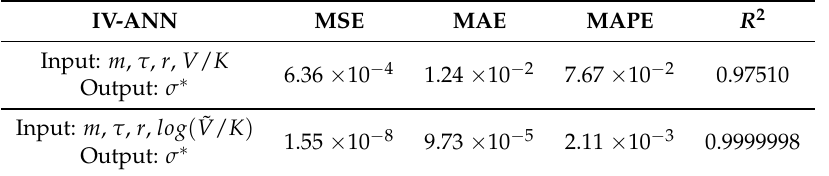
Table 7. Out-of-Sample ANN performance